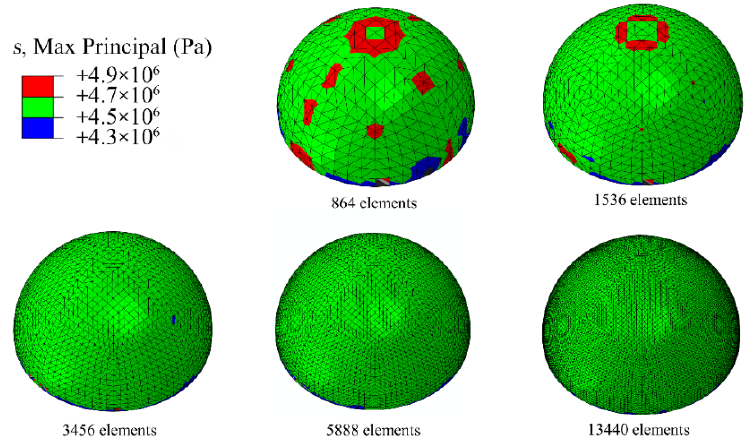
Figure 8. Contours of membrane stress with different mesh levels.